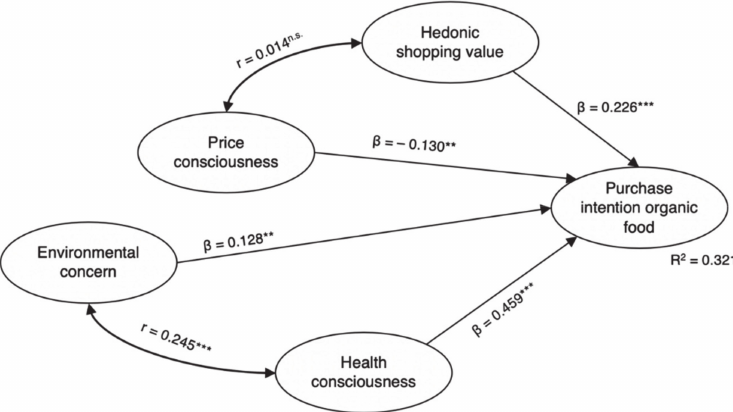
Figure 3. Results for structural model. Notes: β = standardized regression coe ffi cient; R 2 = coe ffi cient